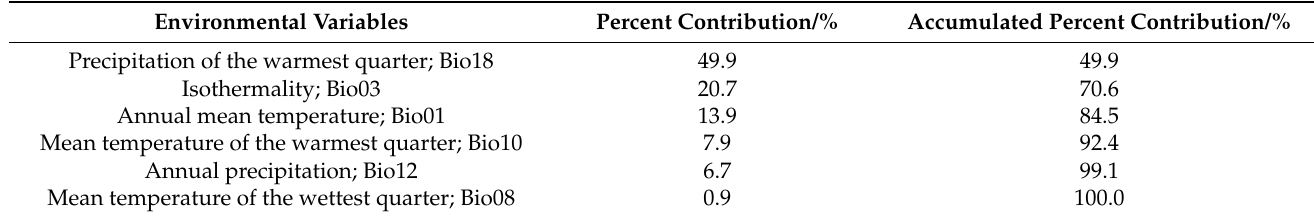
Table 3. The accumulated contribution of selected environmental variables to the potential distribu- tion of all hosts of M. raddei defined by